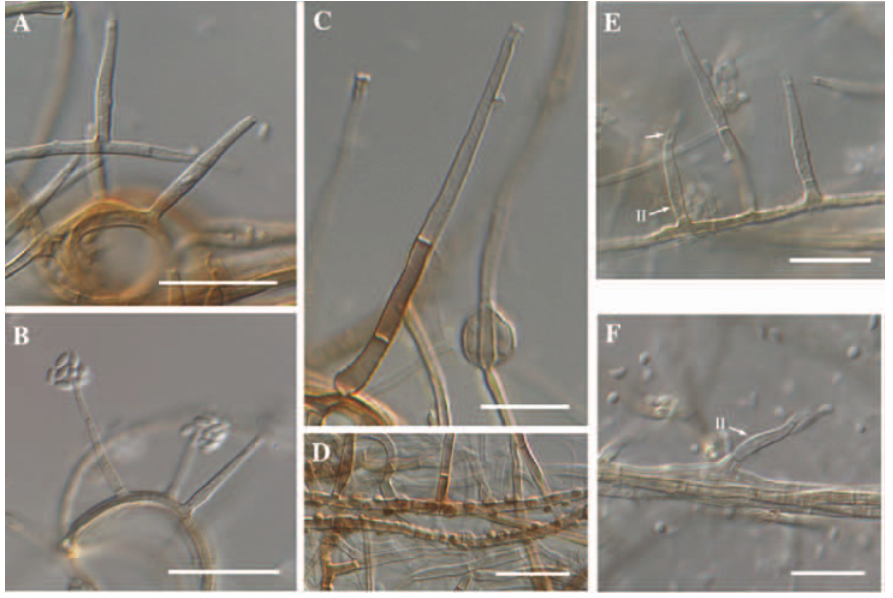
1. Symptoms associated with Petri disease (A–C) and esca (D–F). A. Black spots visible on the rootstock, ‘101- 14 Mgt’ of a one-year-old vine. B. Black streaking associated with natural pruning wound infection of a 9-year-old ‘Shiraz’ vine. C. Spur showing typical brown to black streaking 14 months after inoculated with spore suspension of Pa. chlamydospora on the pruning wound. D and E. Cross section showing different wood discoloration and ‘tiger stripes’ on the leaves of an 18-year-old ‘Chenin blanc’ vine. F. Brown spots or ‘black measles’ symptoms on berries